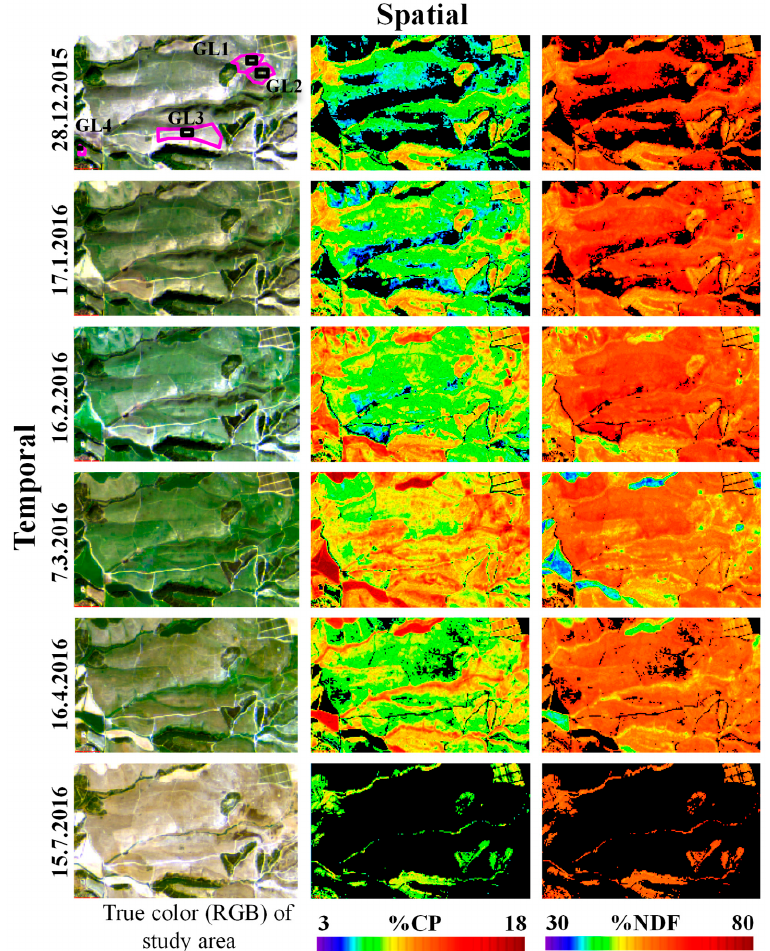
Figure 7. Temporal changes in CP (middle) and NDF (right) contents of the study area. The black pixels are masked pixels (NDVI < 0.35). The magenta-bounded areas on the 28 December 2015 image are the study plots (GL1–GL4), and the black rectangles indicate the sampling locations in each plot. Note also that the RGB version (left) shows variability in vegetation color/properties. The left panel shows the estimated spatial CP maps obtained using the reflectance (b) and the FD (c) models, while the right panel (d, e) shows the frequency distribution of the estimated CP values, for the same pixels produced by each model. Note that the reflectance model was found to be slightly less accurate than FD (index of agreement = 0.72 vs 0.71 and R 2 = 0.76 vs 0.71 (Table 1), consequently). The maps were generated for a Sentinel-2 image from 21 April 2017, and they highlight the differences between the two models. In the reflectance-based map (b), the CP values were higher in the dense vegetative areas, while the FD-based map (c) was a noisy image, with a salt-and-pepper appearance that made the interpretation of results difficult. In addition, the frequency distribution of CP values was overestimated in the FD-based map, with an average value